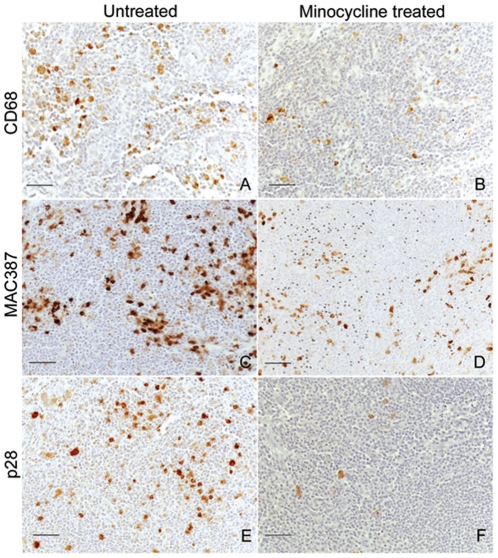
Reduced CD68+, MAC387+, and SIV p28+ productively infected cells in lymph nodes with minocycline treatment.Immunohistochemistry was performed to compare CD68+ resident macrophages, newly infiltrating MAC387+ monocytes/macrophages, and SIV-infected cells in the axillary lymph node from untreated and minocycline treated animals. A reduced number of resident CD68+ macrophages (A–B) and newly infiltrating MAC387+ monocytes/macrophages (C–D) in an axillary lymph node of minocycline treated animals (B, D) and an untreated controls (A, C). In addition, there was a significantly higher number of productively infected SIV p28+ cells in the lymph node of untreated animals (E) compared to minocycline treated animals (F). All scale bars are 50 µm.